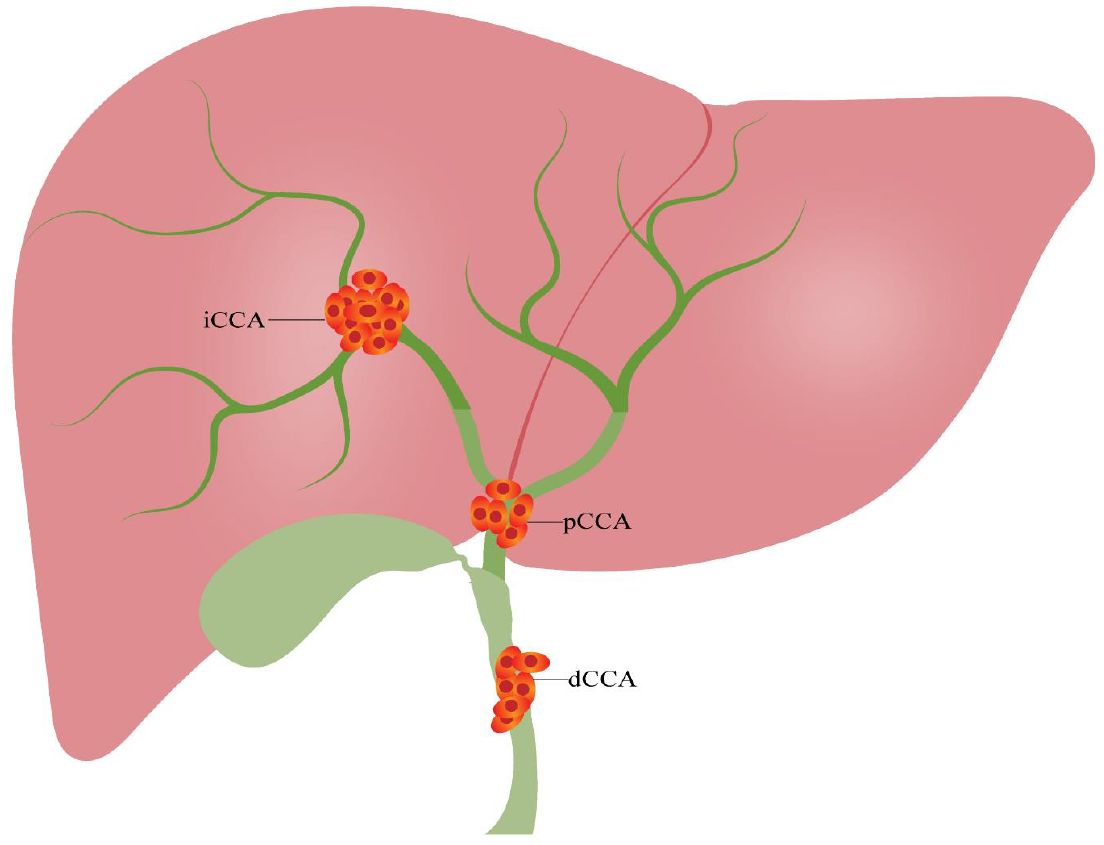
Figure 1. Classification of cholangiocarcinoma. Cholangiocarcinoma can be divided into three cate- gories based on the anatomical location: iCCA, pCCA and dCCA. dCCA, distal cholangiocarcinoma; iCCA, intrahepatic cholangiocarcinoma; pCCA, perihilar cholangiocarcinoma. Single-nucleotide polymorphisms (SNPs) are polymorphisms of a DNA sequence caused by a single nucleotide variation at the genomic level between individuals (Figure